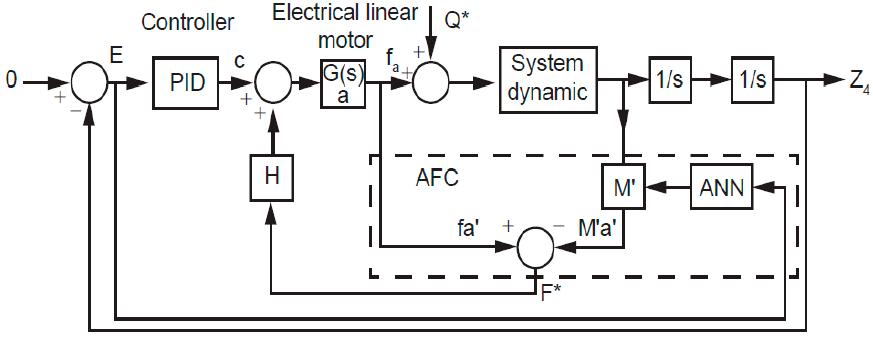
Figure 18. Representation block of active force control scheme [108].